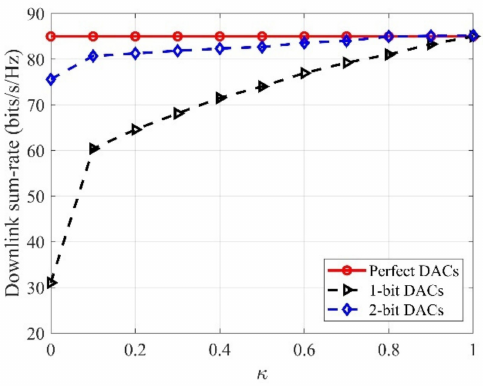
Figure 5. Downlink sum-rate versus the κ for different quantization bits, with M = 60, N = 10, K = 10. Last but not least, Figure 6 investigates the impact of the κ for the downlink per-user rate for the general fairness principle ( ω k = 1, ∀ k ), with M = 60, N = 10, K = 10. Along with the κ increase, the downlink per-user rate can be sharply enhanced and the gaps between different curves are decreased. The results show that when the system uses low- resolution quantization, increasing κ contributes to raising the system sum rate. Focusing on the general fairness principle, the achievable downlink rate is more concentrated around a certain value compared with the case without the max–min algorithm. This confirms that the proposed algorithm can guarantee uniform